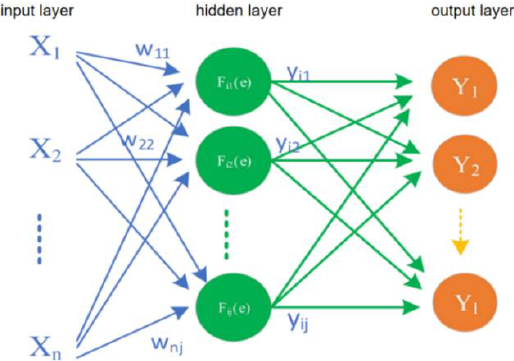
Figure 4. Topological structure of the BP neural network.